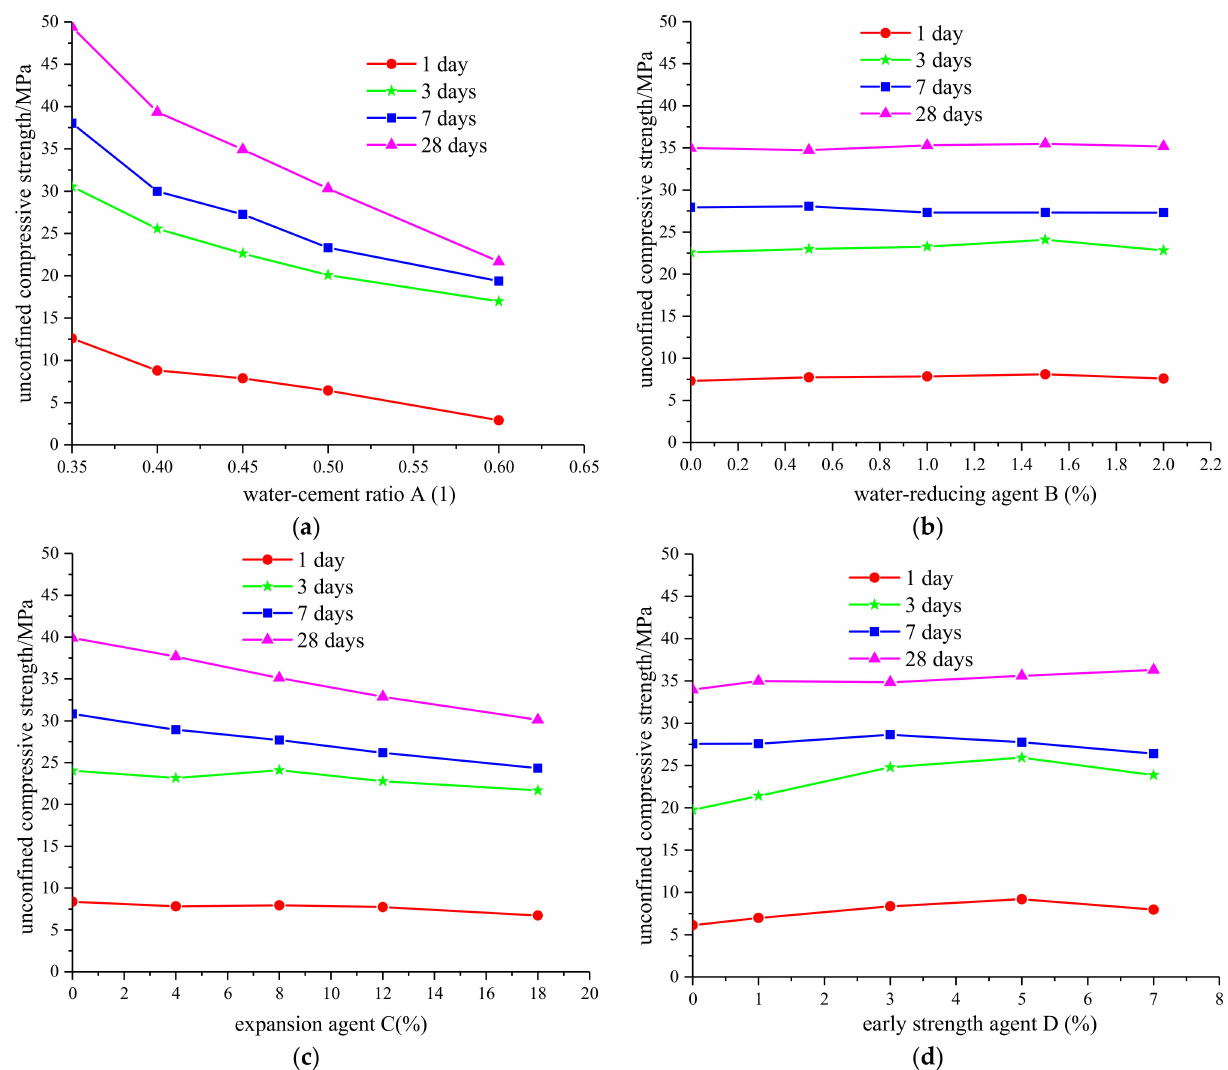
Figure 3. The influence of various factors on the development trend of compressive strength. ( a ) Influence of water–cement ratio on compressive strength; ( b ) influence of water-reducing agent on compressive strength; ( c ) influence of expansion agent on compressive strength; ( d ) influence of early-strength agent on compressive